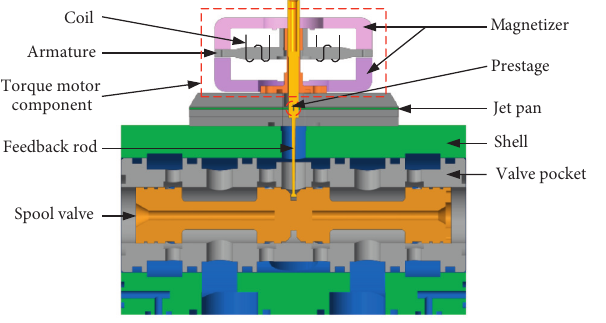
Figure 1: Structure of the DJV.